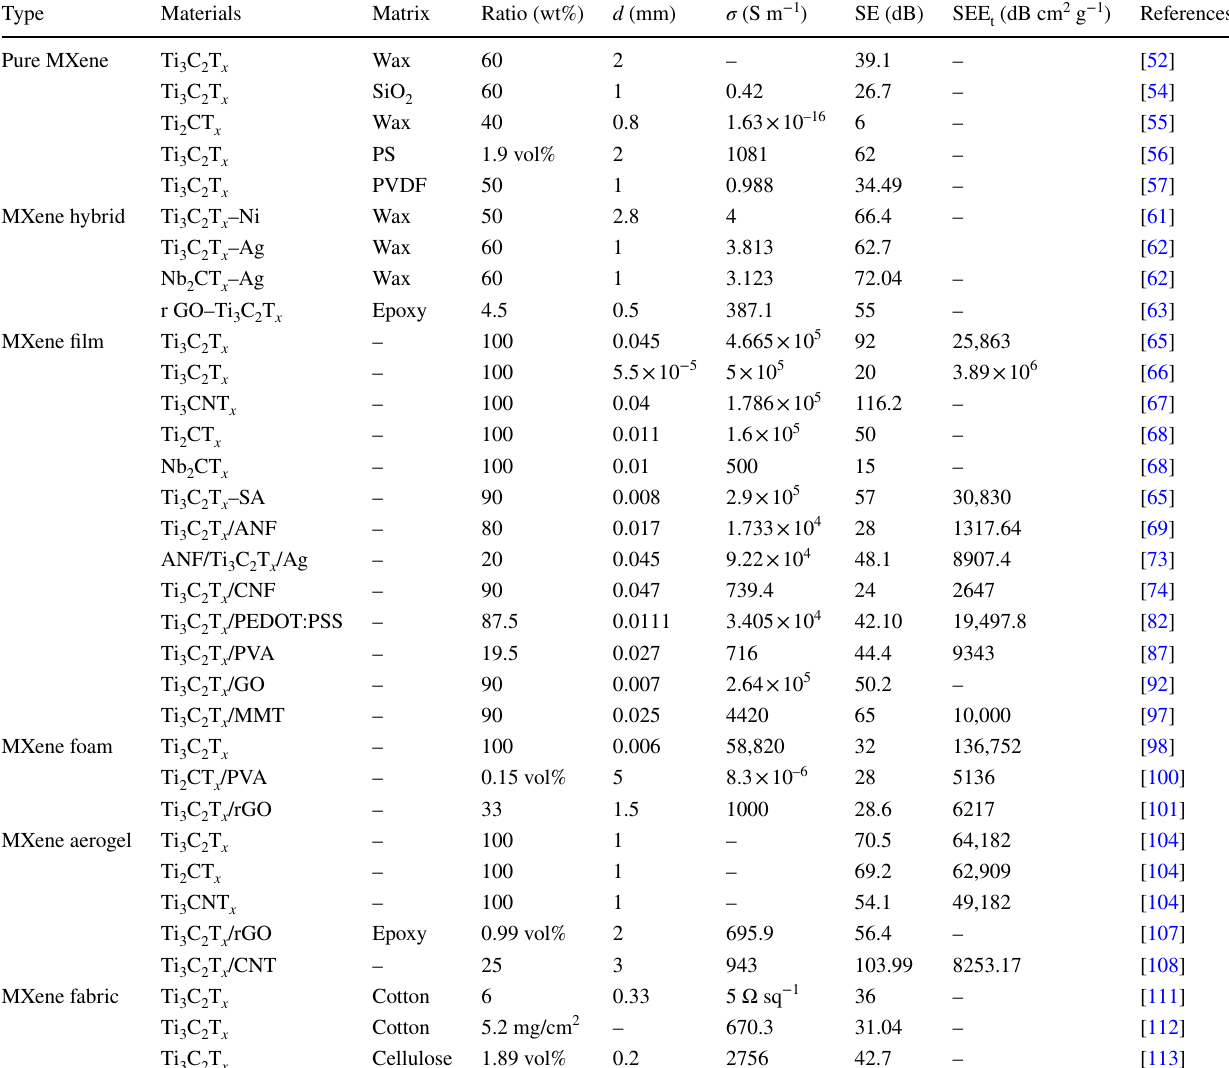
Table 2 Typical MXene‑based materials and their EMI shielding properties